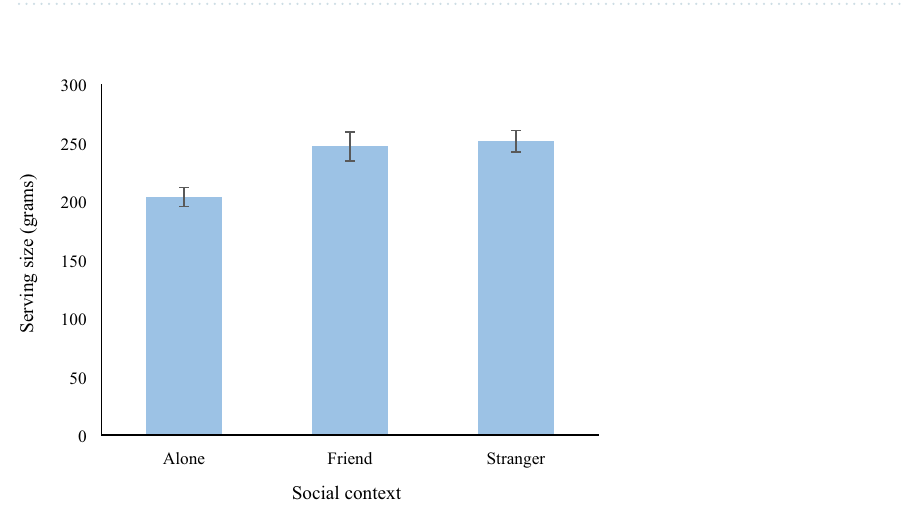
Table 2. Participant characteristics stratified by social context condition. Values are means (standard deviation).